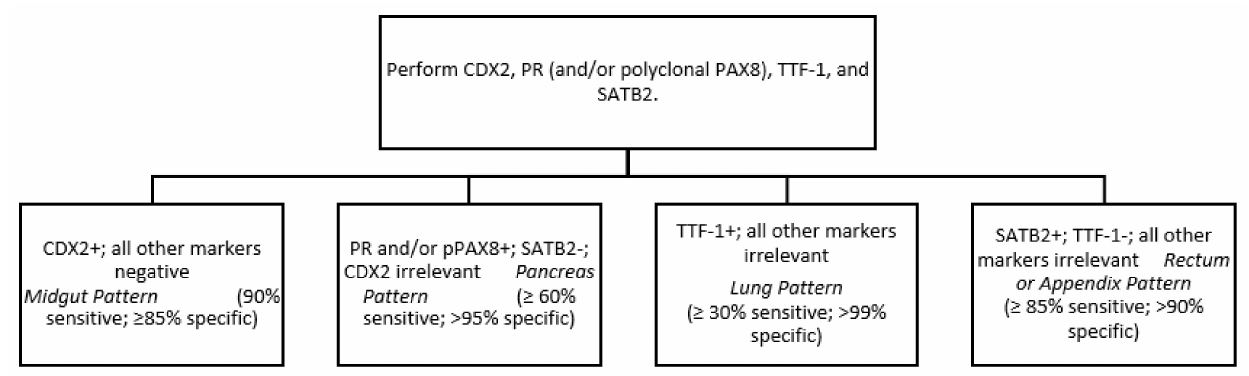
Figure 1. Simplified immunohistochemical algorithm for NETs site of origin by Bellizzi